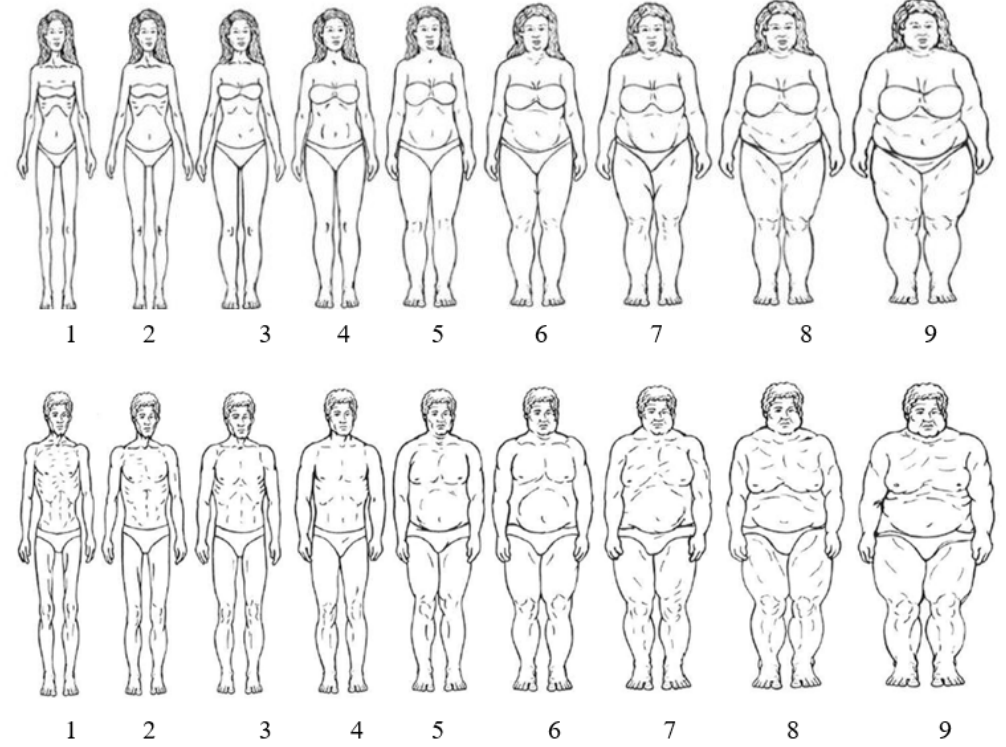
Figure 1. Sex-Specific Figural Stimuli Silhouettes. Female BMI anchors: 1 = 17.8, 2 = 18.8, 3 = 20.3, 4 = 22.6, 5 = 26.4, 6 = 31.3, 7 = 36.7, 8 = 40.8, 9 = 44.1. Male BMI anchors: 1 = 18.8, 2 = 20.2, 3 = 21.4, 4 = 22.9, 5 = 25.4, 6 = 28.2, 7 = 33.1, 8 = 35.8, 9 = 49.4.